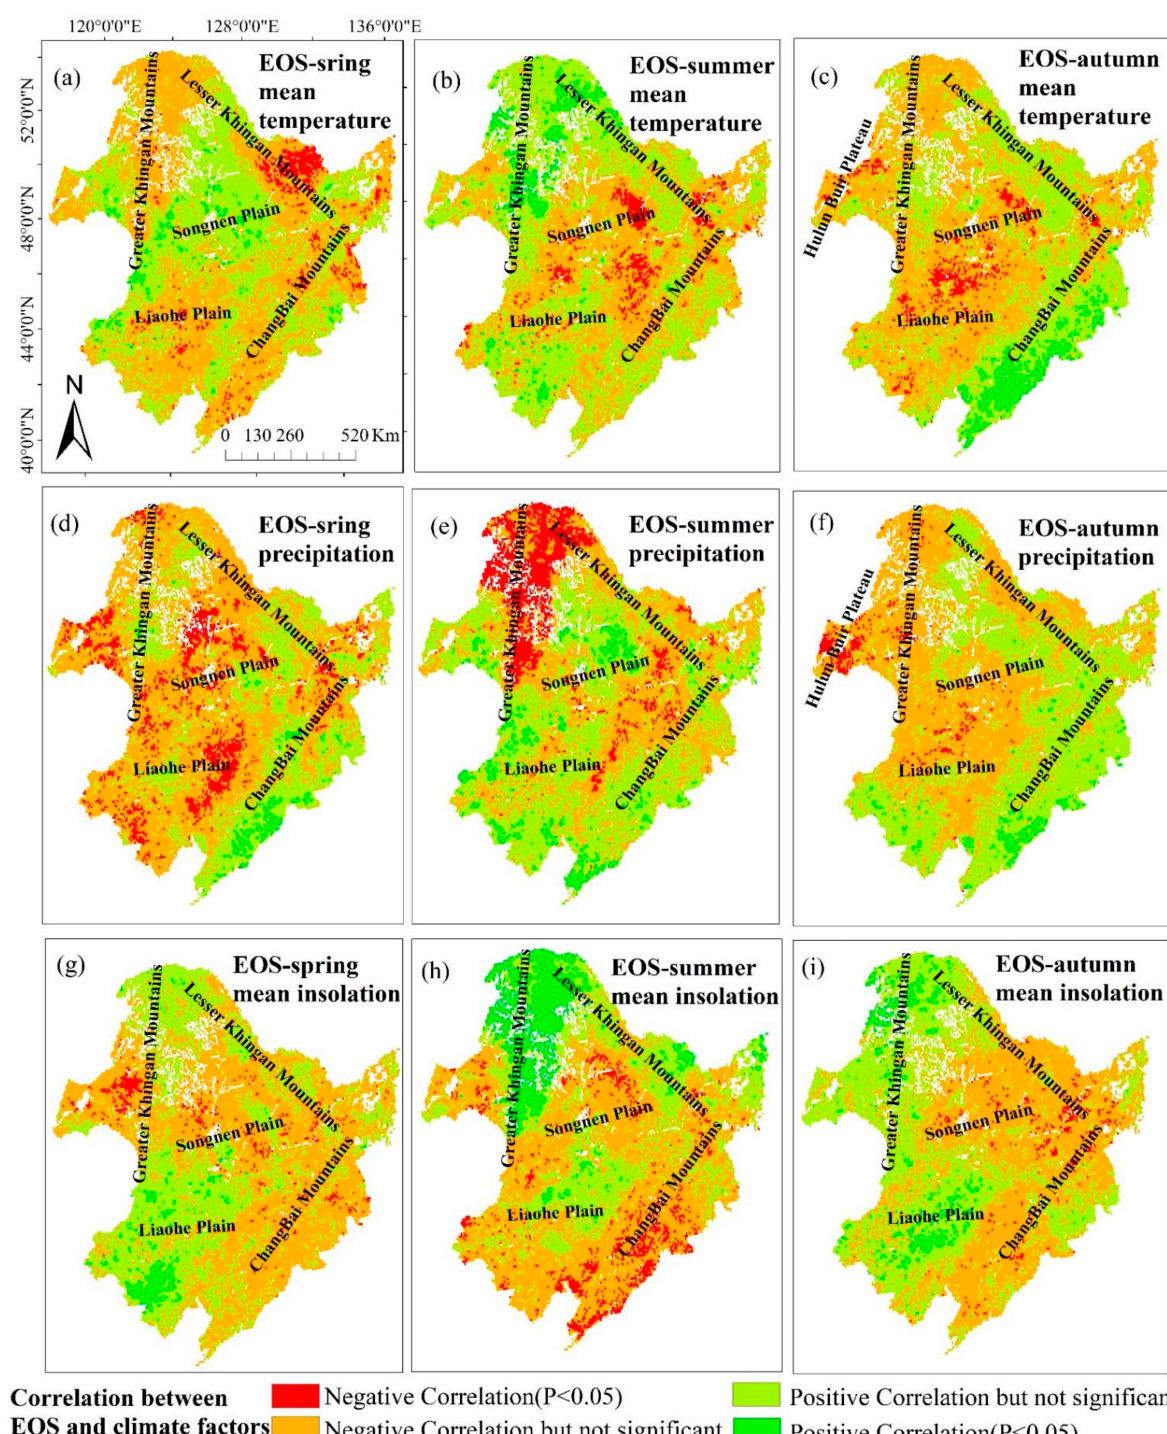
Figure 7. Correlation of EOS and climate variables of northeast China in 1982–2014. ( a , b , c ) present cor- relations between EOS and spring mean temperature, summer mean temperature, and autumn mean temperature, respectively. ( d , e , f ) present correlations between EOS and spring total precipitation, summer total precipitation, and autumn total precipitation, separately. ( g , h , i ) present correlations between EOS and spring mean insolation, summer mean insolation, and autumn mean insolation,